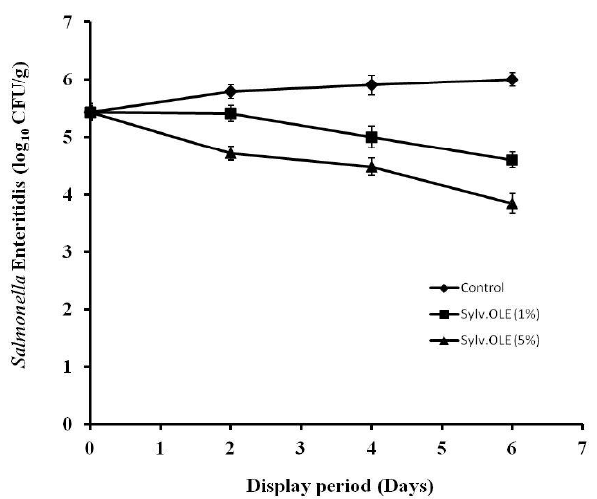
Figure 4. Salmonella enterica ser. Enteritidis growth rate in HMB during display in the presence of different sylv . OLE